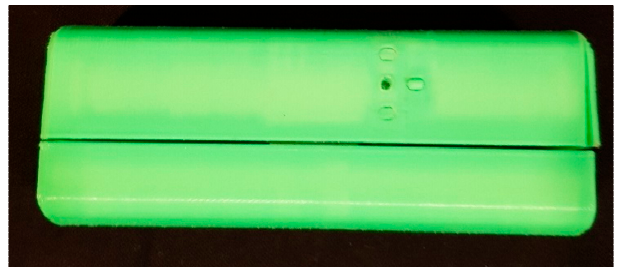
Figure 1. BodyGrip dynamometer prototype.